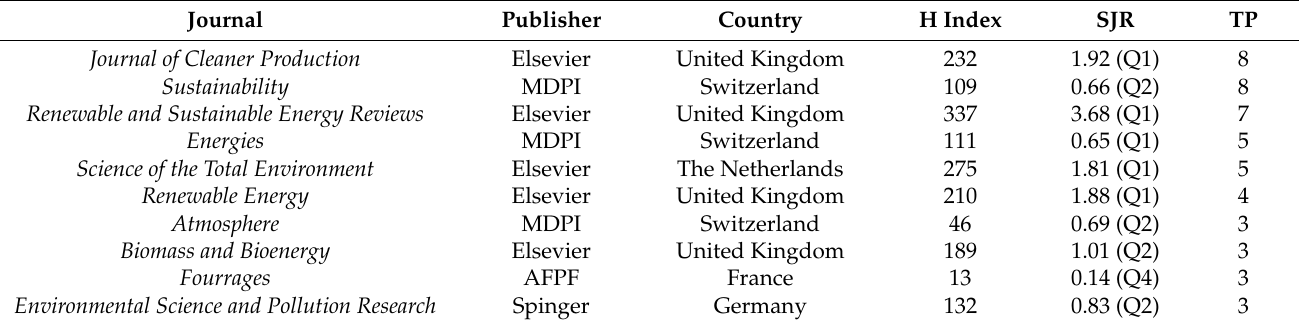
Table 2. List of the most relevant journals.